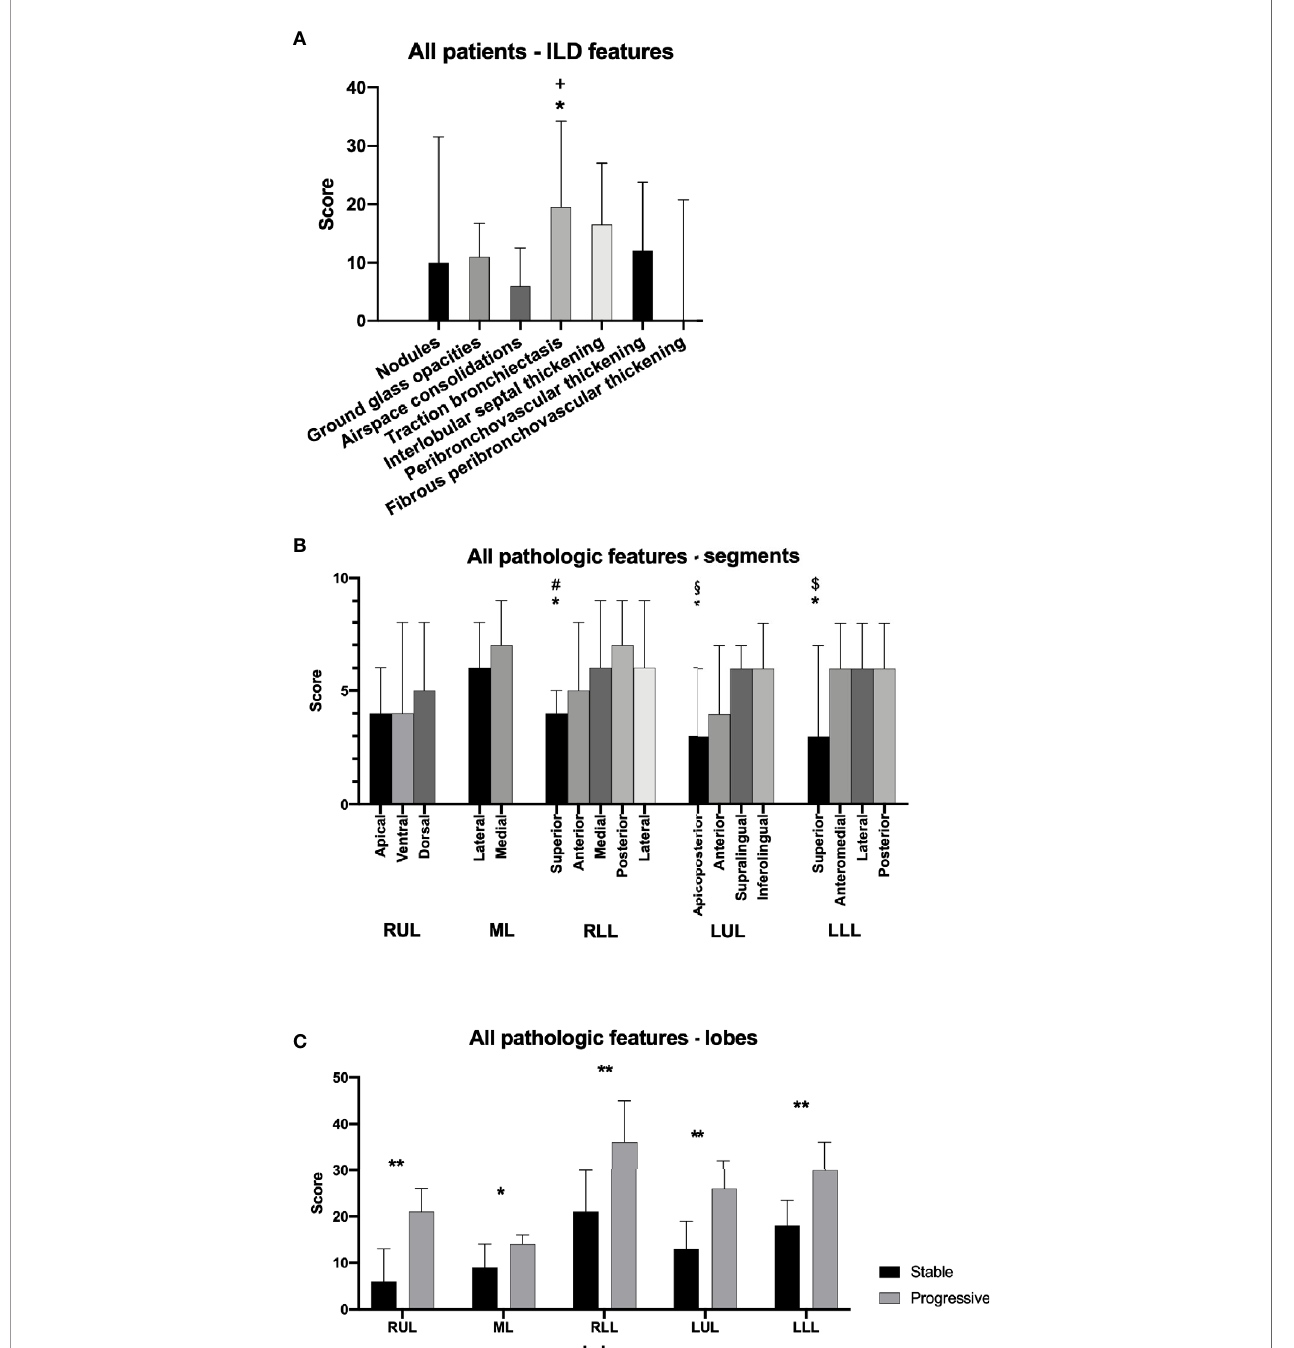
FIGURE 2 | Pathologic features on pulmonary CT scans in granulomatous-lymphocytic interstitial lung disease (GLILD) patients. Overall score for speci fi c features in all patients (A) . Overall score of pathologic features in all pulmonary segments for all patients (B) . Overall score of pathological features in single lobes in patients with stable and progressive disease (C) . RUL, right upper lobe; ML, middle lobe; RLL, right lower lobe; LUL, left upper lobe; LLL, left lower lobe. Median and interquartile range. *p<0.05. **p<0.01. + traction bronchiectasis vs . ground glass opacities, nodules, consolidations, fi bro-/peribronchovascular thickening. # superior vs . lateral. § apicoposterior vs . inferolingual. $ superior vs .